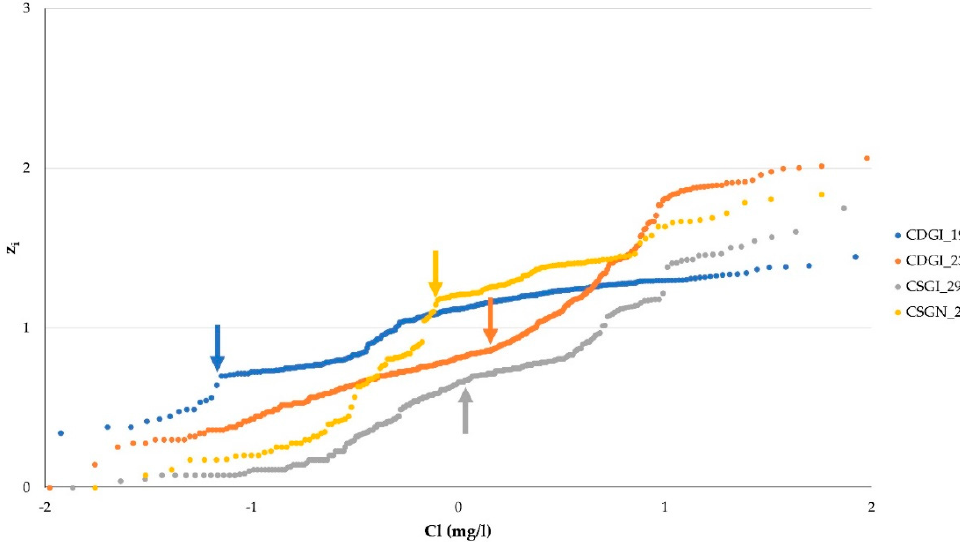
Figure 12. Lognormal probability plot of chloride (Cl) for analysed groundwater bodies. Arrow indicates inflection point that separates ambient and non-ambient populations for each groundwater body.